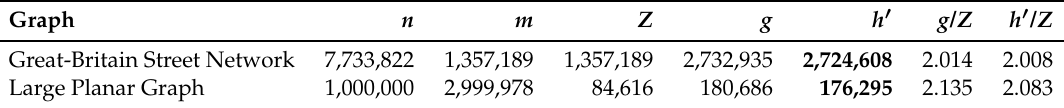
Table 11. Results for Large